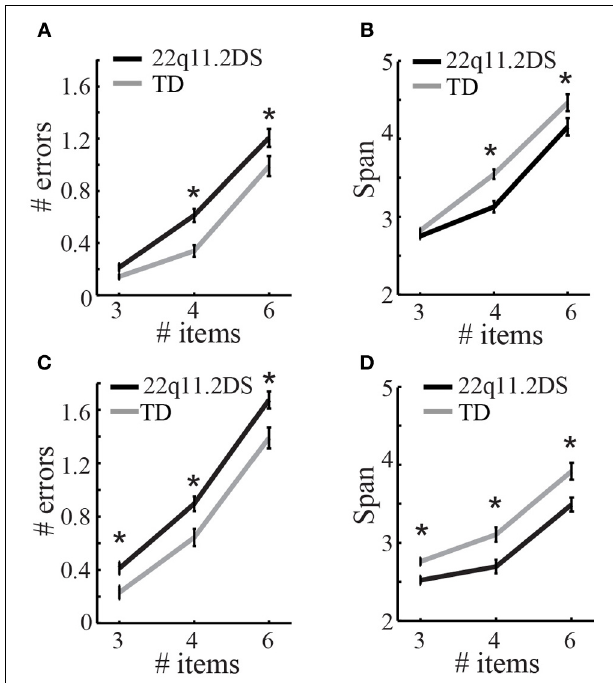
FIGURE 5 | Results of the working memory task, the self-ordered pointing test (SOPT). On the verbal version of the task, children with 22q11.2DS made more errors (A) and had a lower span (B) on the more difficult trials levels with 4 and 6 items to remember ( ∗ p < 0 . 05). On the non-verbal version of the SOPT, children with 22q11.2DS made significantly more errors (C) and had a lower span (D) across all levels of the non-verbal SOPT, when compared to TD children ( ∗ p < 0 .